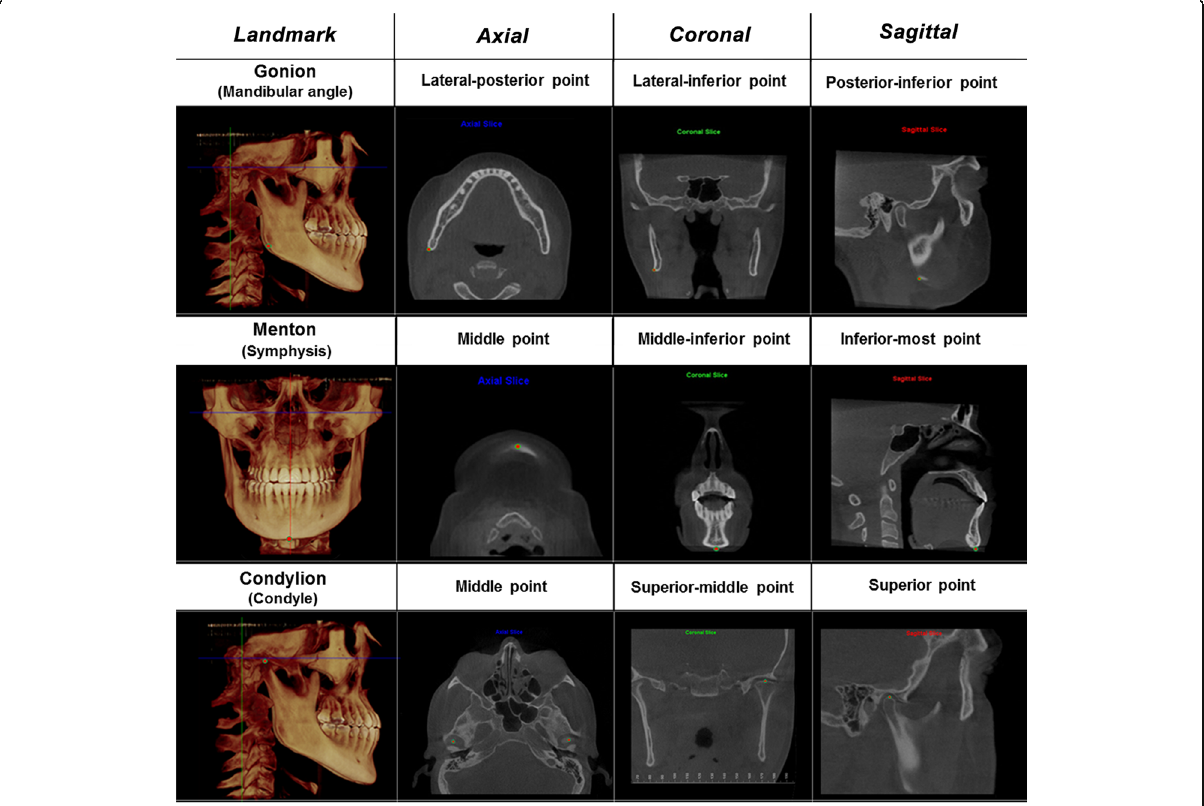
Fig. 2 Mandibular landmarks (gonion, menton, and condylion) defined on volume rendering and multiplanar reconstruction according to axial, coronal, and sagittal slices